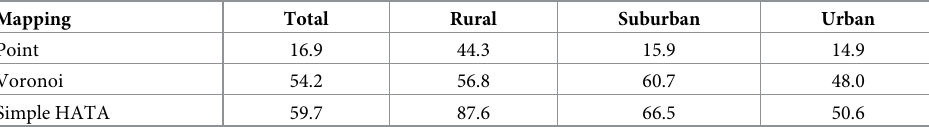
Table 4. Overlap with true home-located settlements